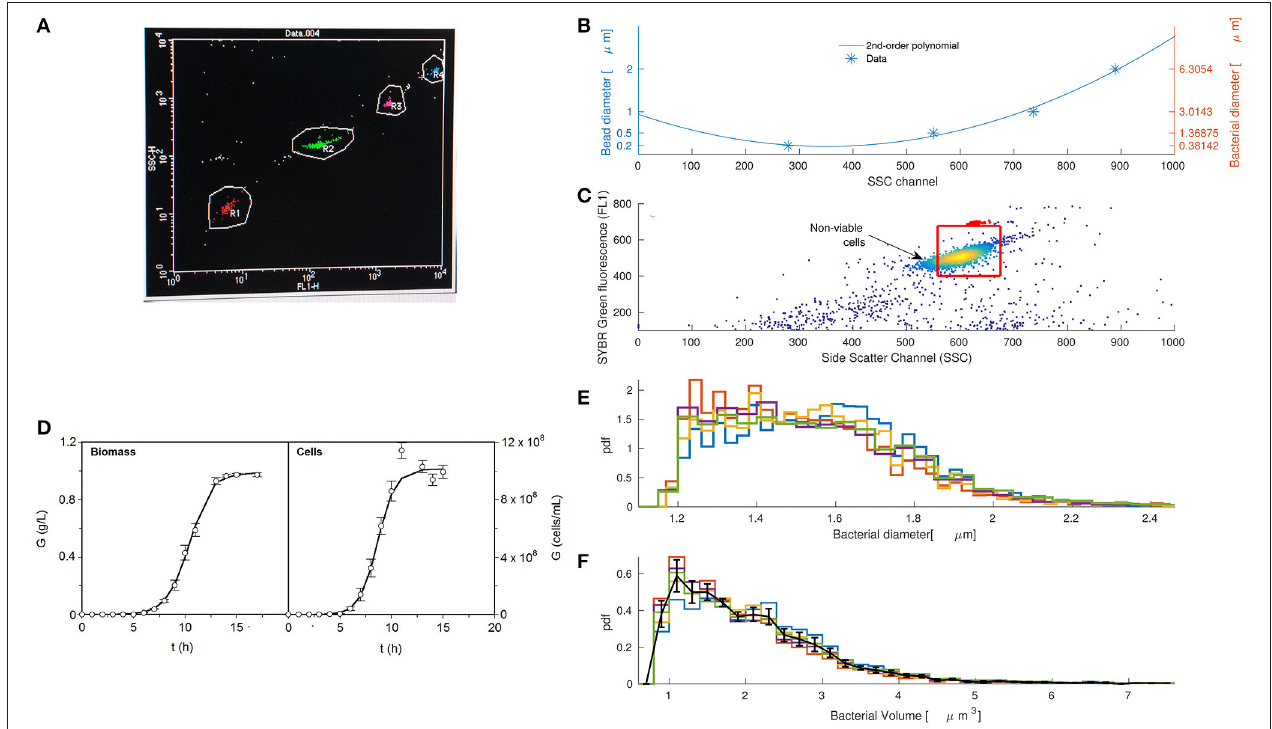
FIGURE 2 | Flow cytometry is an efficient technique to extract volume distributions of coccoid bacteria such as Pediococcus acidilactici . (A) Side scatter light (y-axis) discriminates among round beads of different diameters represented in red, green, pink, and blue for diameters 0.2, 0.5, 1, and 2 µ m , respectively. (B) Bead diameter correlates with side scatter as a second order polynomial (Julià et al., 2000; Prats et al., 2010) and can be transformed into bacterial diameter following the linear relationship in Chandler et al. (2011). (C) Flow cytometry correlogram and gating (red box) of fluorescent dye Sybrgreen with side scatter light for Pediococcus acidilactici after 8h of growth. (D) Growth kinetics of P. acidilactici in terms of biomass and cell counting shows that the selected time where we took the sample ( t = 8h) is within the exponential phase (error bars are the confidence of intervals for n = 5 and α = 0.05). (E) Estimated diameter distribution of five replicas of the population of Pediococcus acidilactici at time 8. (F) Population volume distributions of Pediococcus acidilactici at time